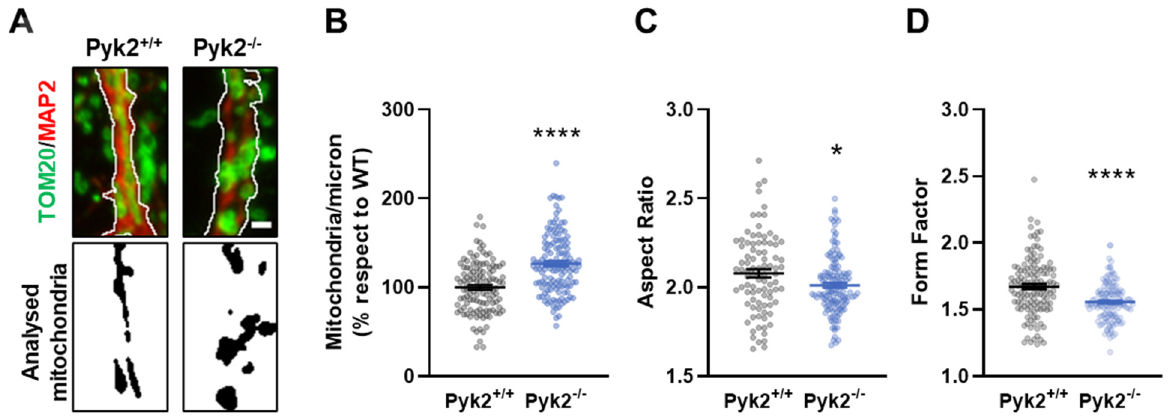
Figure 6. Alterations in mitochondrial morphology in Pyk2 − / − primary hippocampal neurons. Hippocampal primary neurons from Pyk2 +/+ and Pyk2 − / − embryos were cultured until DIV21. ( A ) In the upper panel, confocal images of immunolabeling of hippocampal primary neurons with TOM20 (green) and MAP2 (red). White lines delimit the analysed region. In the lower panel, correspondent binary image with the analysed mitochondria in black with white background. Scale bar, 1 micron; ( B – D ) Pyk2 − / − neurons presented mitochondrial fragmentation as indicated by three different parameters namely: Increased ( B ) number of mitochondria per micron (Student t -test, t = 6.834, df = 258; p < 0.0001); lower ( C ) Aspect Ratio (Mann–Whitney t -test, A: 11,659, B: 14906, U: 5036, p = 0.0101) and lower ( D ) Form Factor (Mann–Whitney t -test, A: 20,567, B: 15,748, U: 5878, p < 0.0001). Data are means ± SEM of 15–20 neurons from 8 different embryos per genotype (n = 128–140). * p < 0.05, **** p < 0.0001 vs. Pyk2 +/+ .